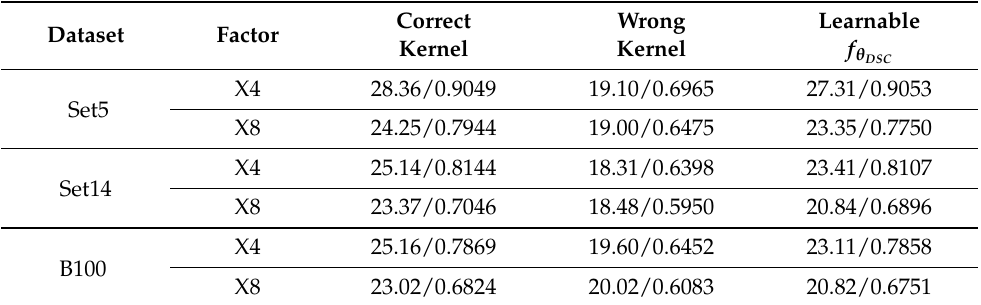
Table 1. Comparison of quantitative evaluation on Bicubic downsampled LR images using f DSC the pre-defined and learnable kernels. The first and second numerals represent the PSNR and SSIM values, respectively.